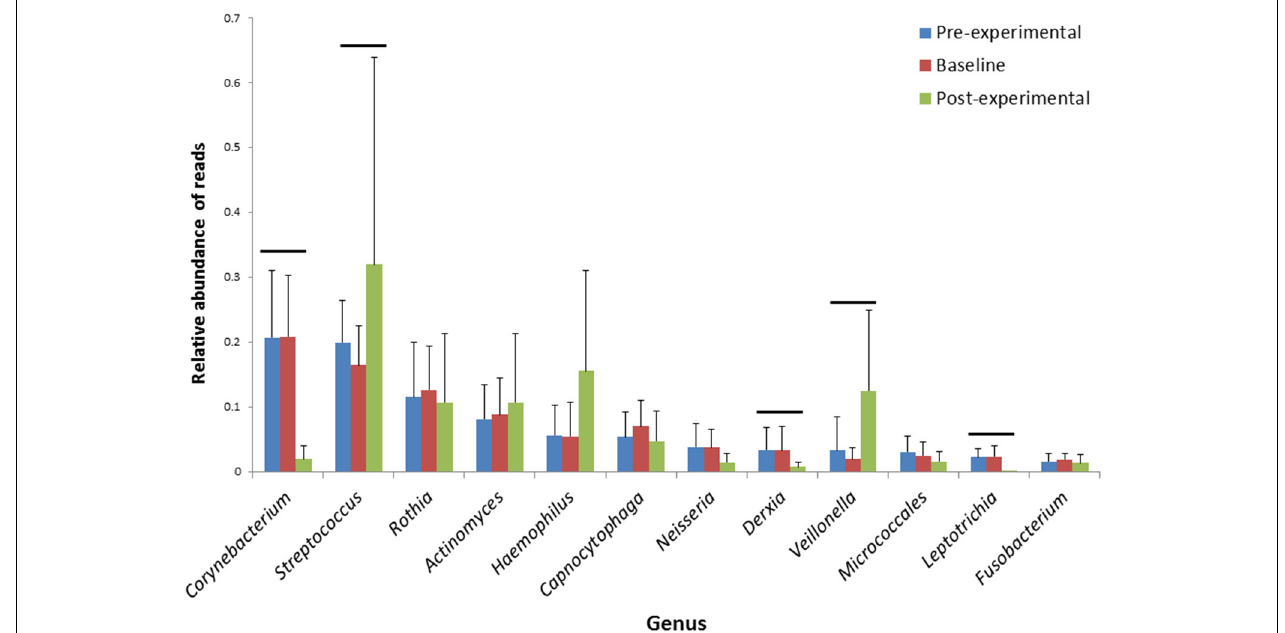
FIGURE 3 | Average proportions of major genera from dental plaque samples collected at pre-experimental, baseline and the post-experimental visit. Error bars—standard deviations. Horizontal lines indicate statistically significantly different